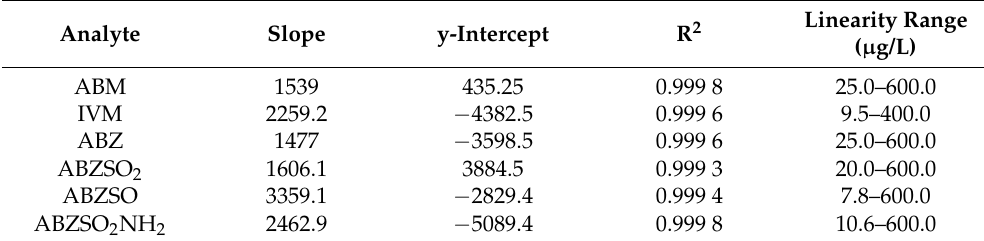
Table 3. Linear regression equations, R 2 values and linearity ranges of six